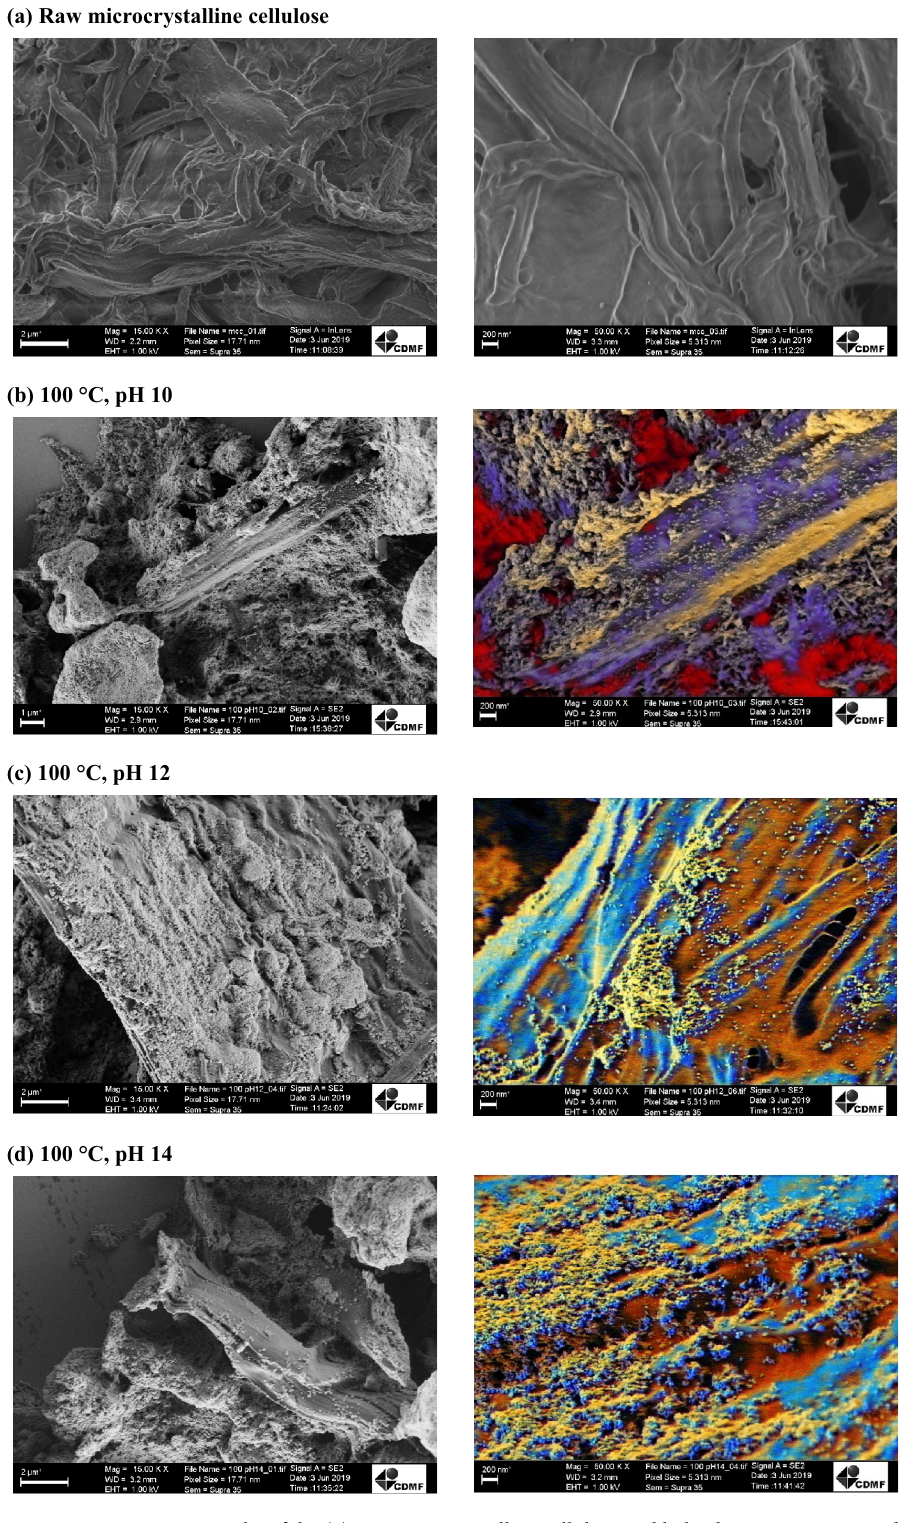
Figure 2. SEM micrographs of the ( a ) raw microcrystalline cellulose and hybrid structures prepared with the MAH route at ( b ) 100 °C, pH 10, ( c ) 100 °C, pH 12, ( d ) 100 °C, pH 14, ( e ) 120 °C, pH 10, ( f ) 120 °C, pH12 and ( g ) 120 °C, pH